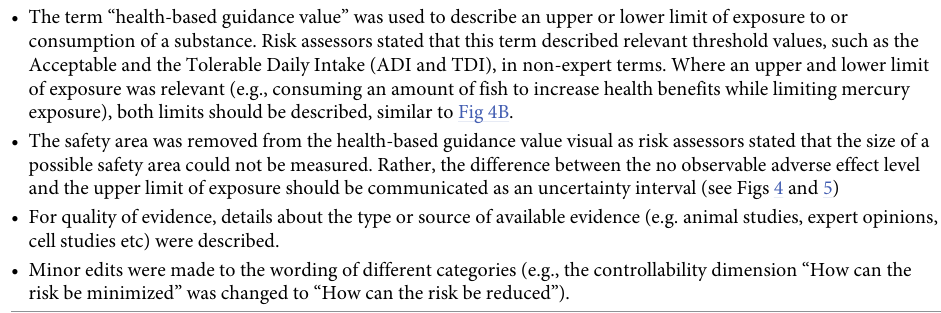
Table 4. Summary of modifications to the prototype V2 from usability